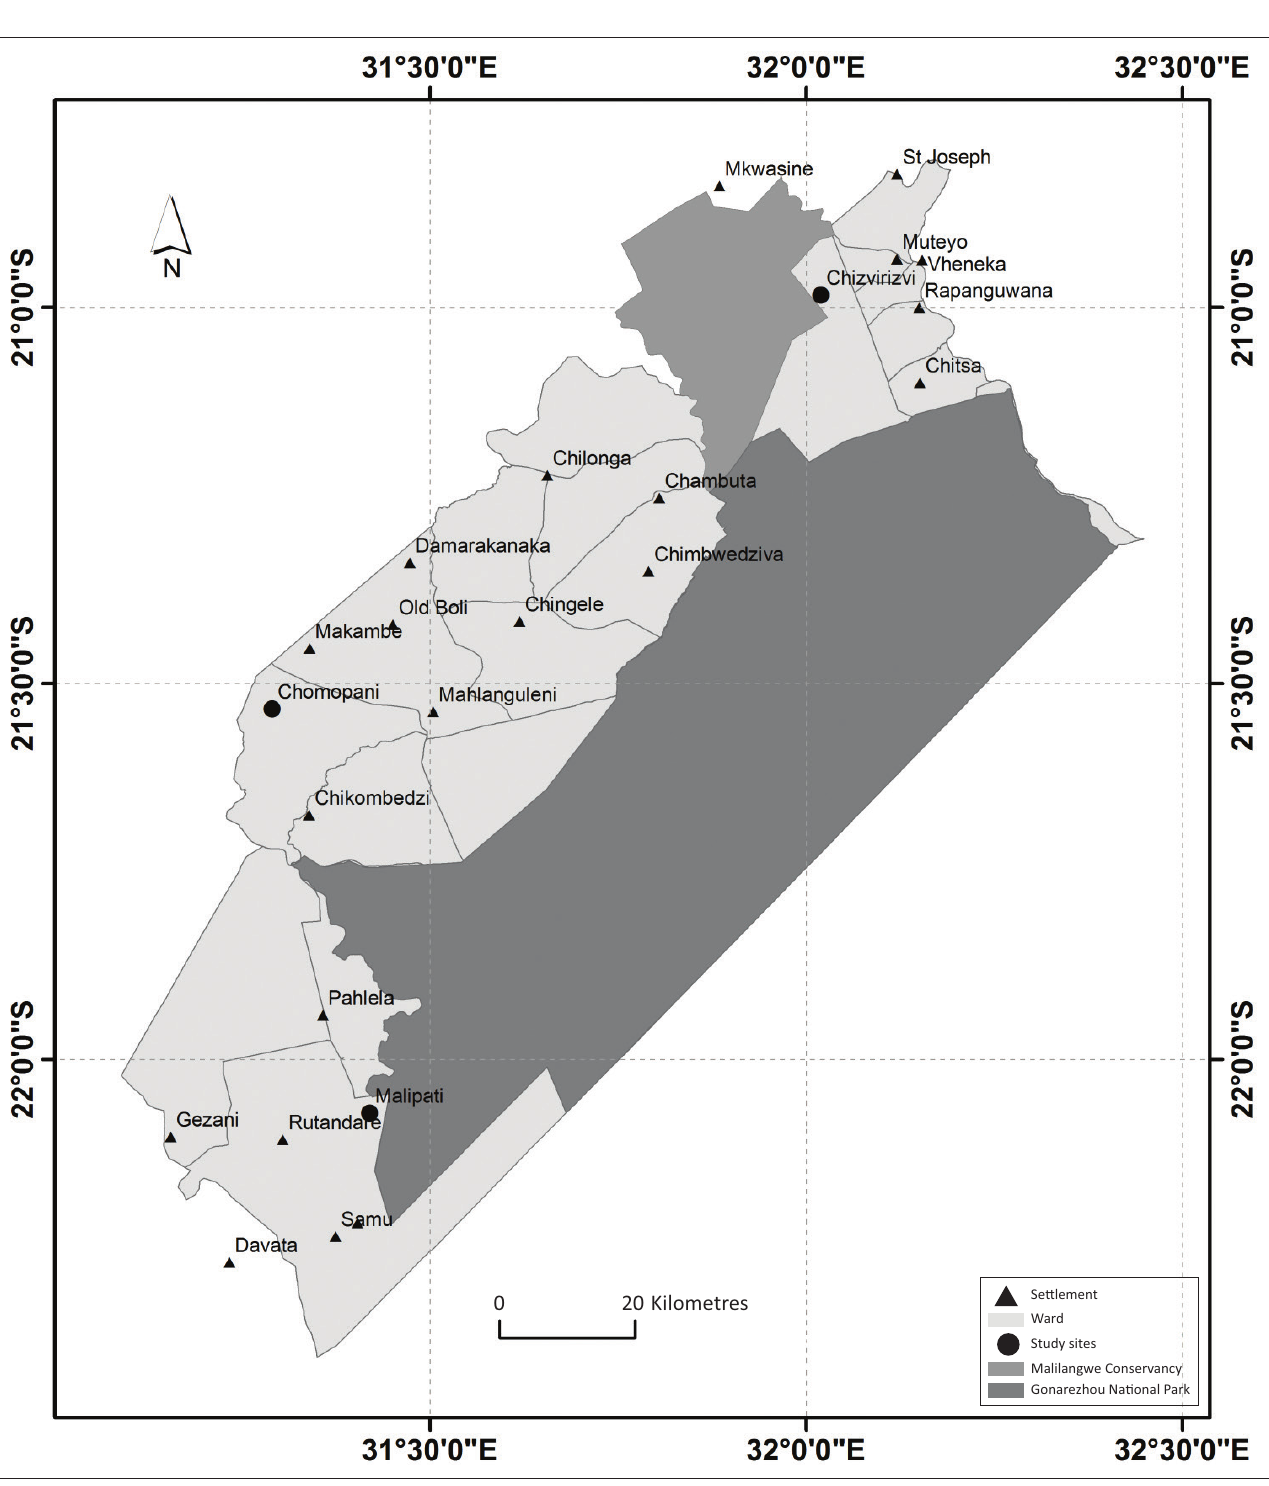
FIG URE 1: Map of the southeastern Lowveld of Zimbabwe showing the Gonarezhou National Park and the adjacent Malilangwe Conservancy. Note the three study sites represented by big black